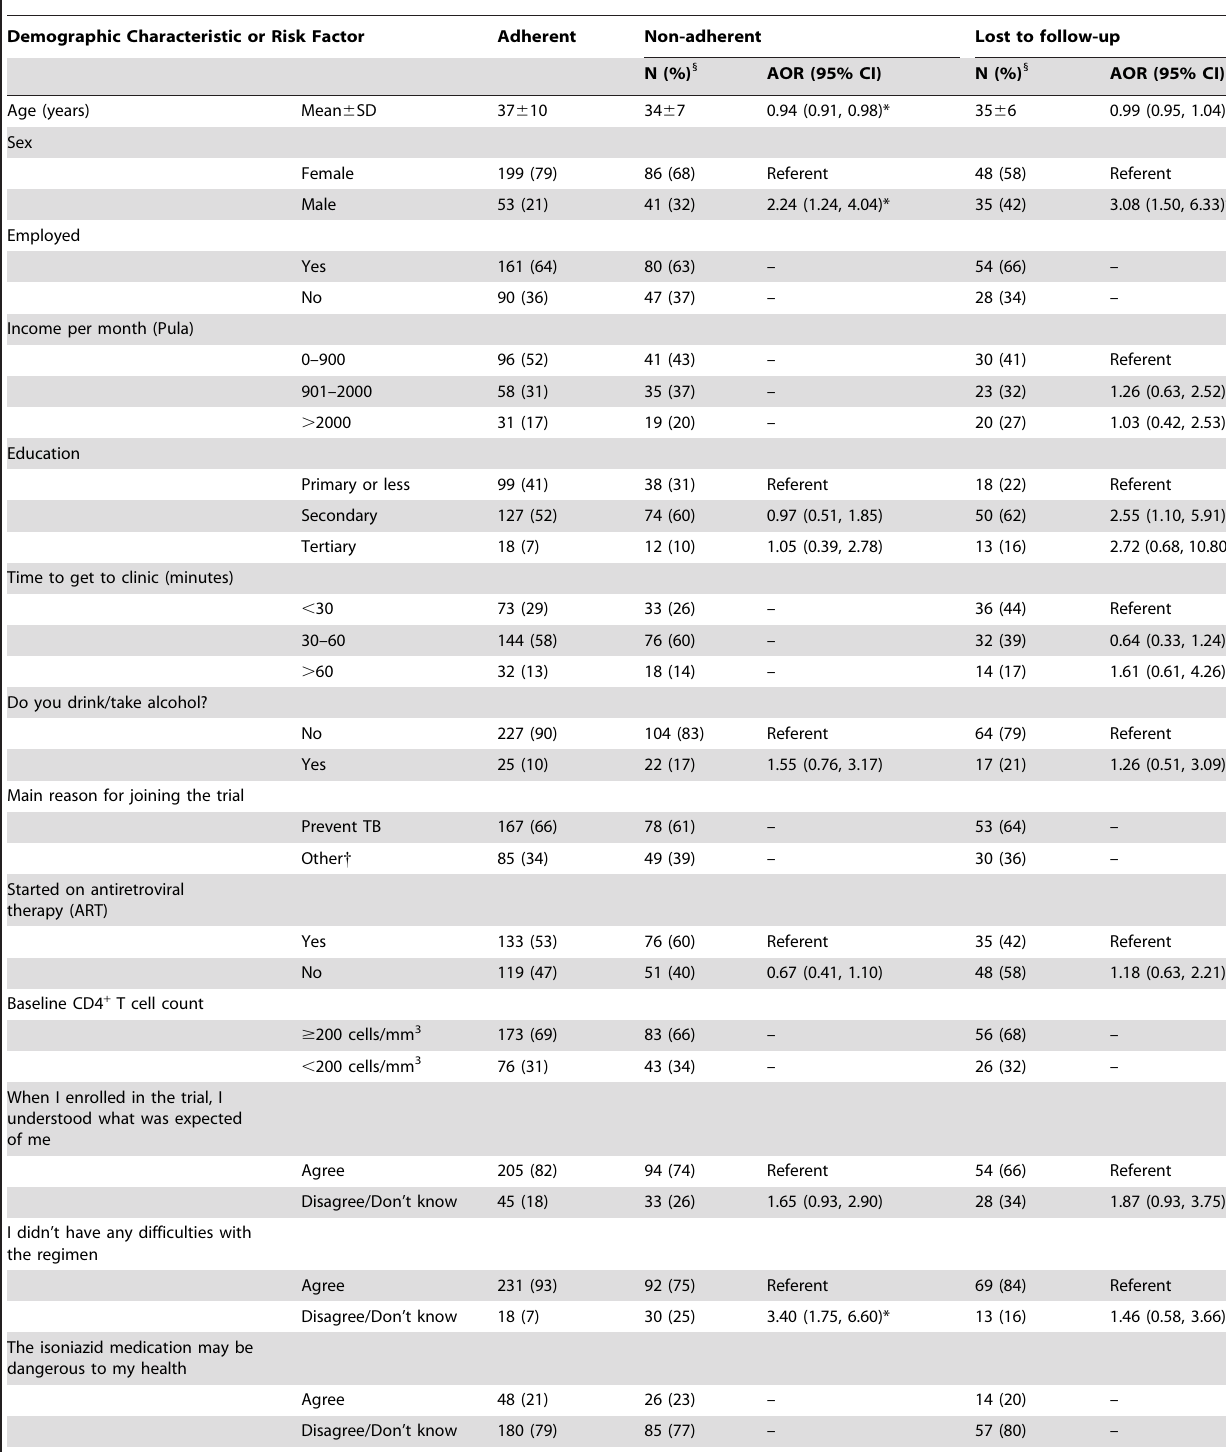
Table 4. Risk factor analysis using multivariate logistic regression analysis for non-adherence and loss to follow-up in a cohort of HIV-infected adults enrolled in the Botswana Isoniazid Preventive Therapy Trial,